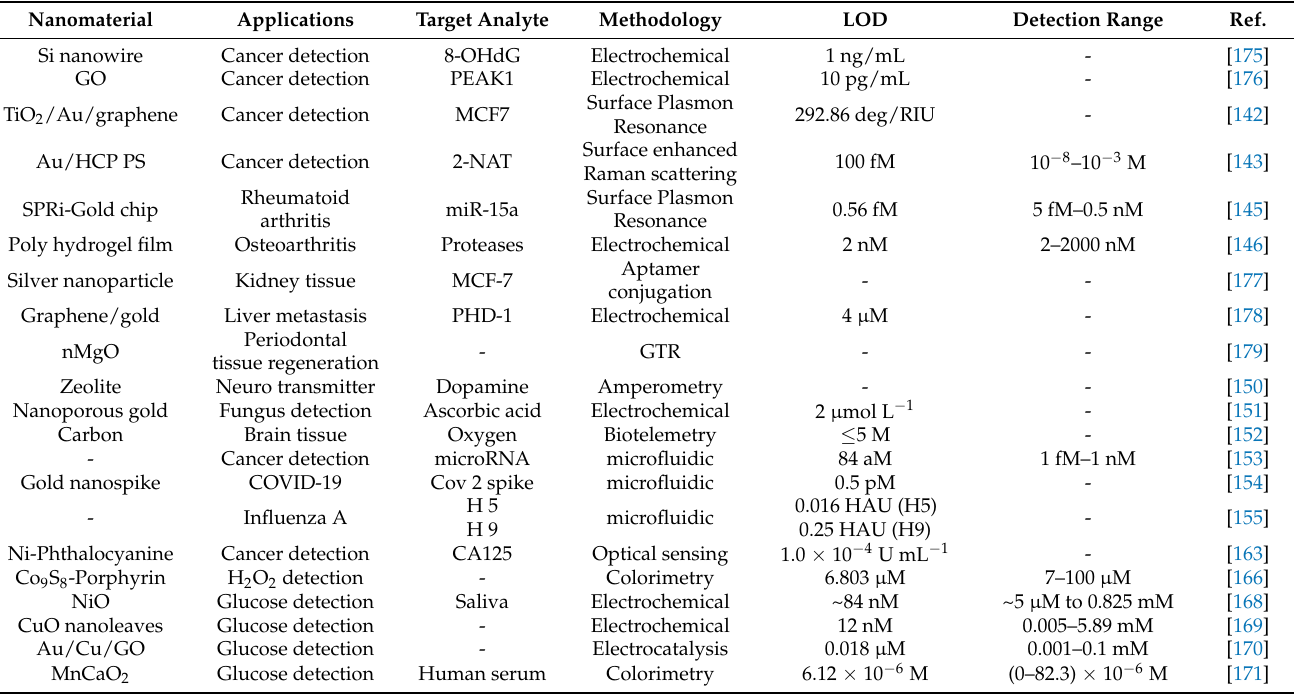
Table 2. List of nanomaterials used for various biosensing